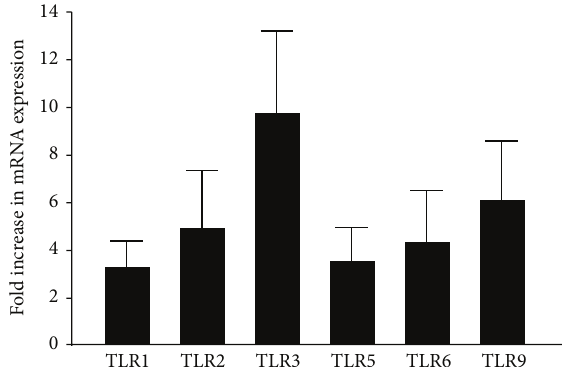
Figure 7: Wounding stimulated TLR expression in submerged primary conjunctival epithelial cells. Confluent cells were scratched by sterile surgical blade at about 1cm interval and harvested 24 hrs later for RNA extraction and qPCR analysis. The experiment was repeated in 3 different batches of primary cells, and the averaged changes were shown. 𝑌 error bars represent the standard deviation of the averaged results. The increase was statistically significant for each